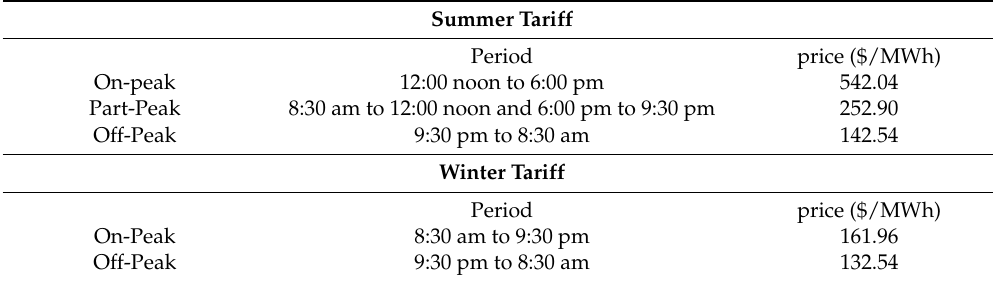
Table 1. Time of use (TOU)